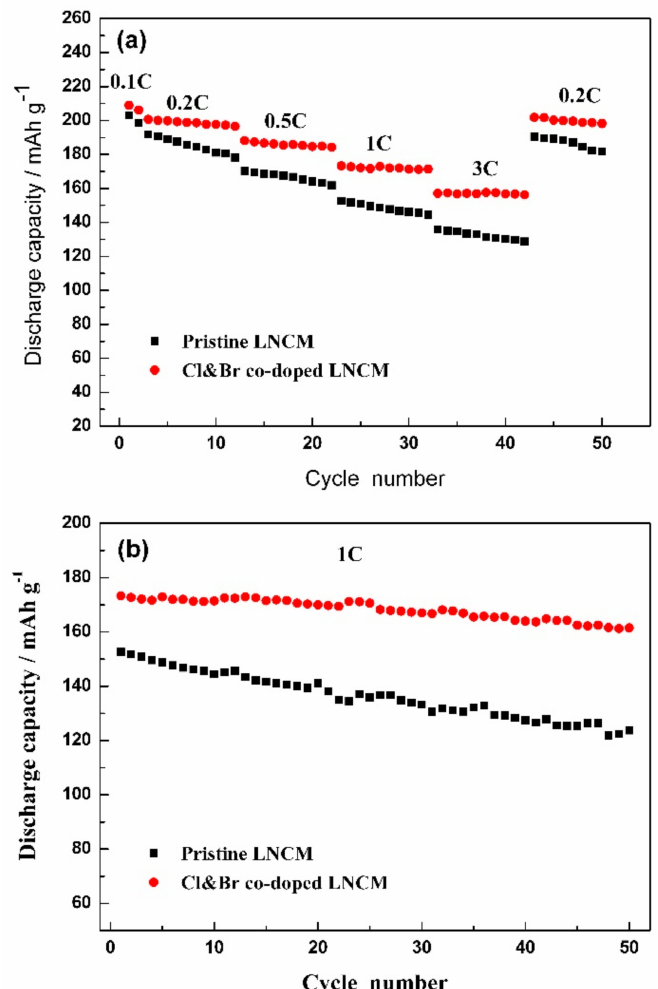
Figure 5. Rate capabilities ( a ) and cycling performance ( b ) of the synthesized LiNi 1/3 Co 1/3 Mn 1/3 O 2 compounds.